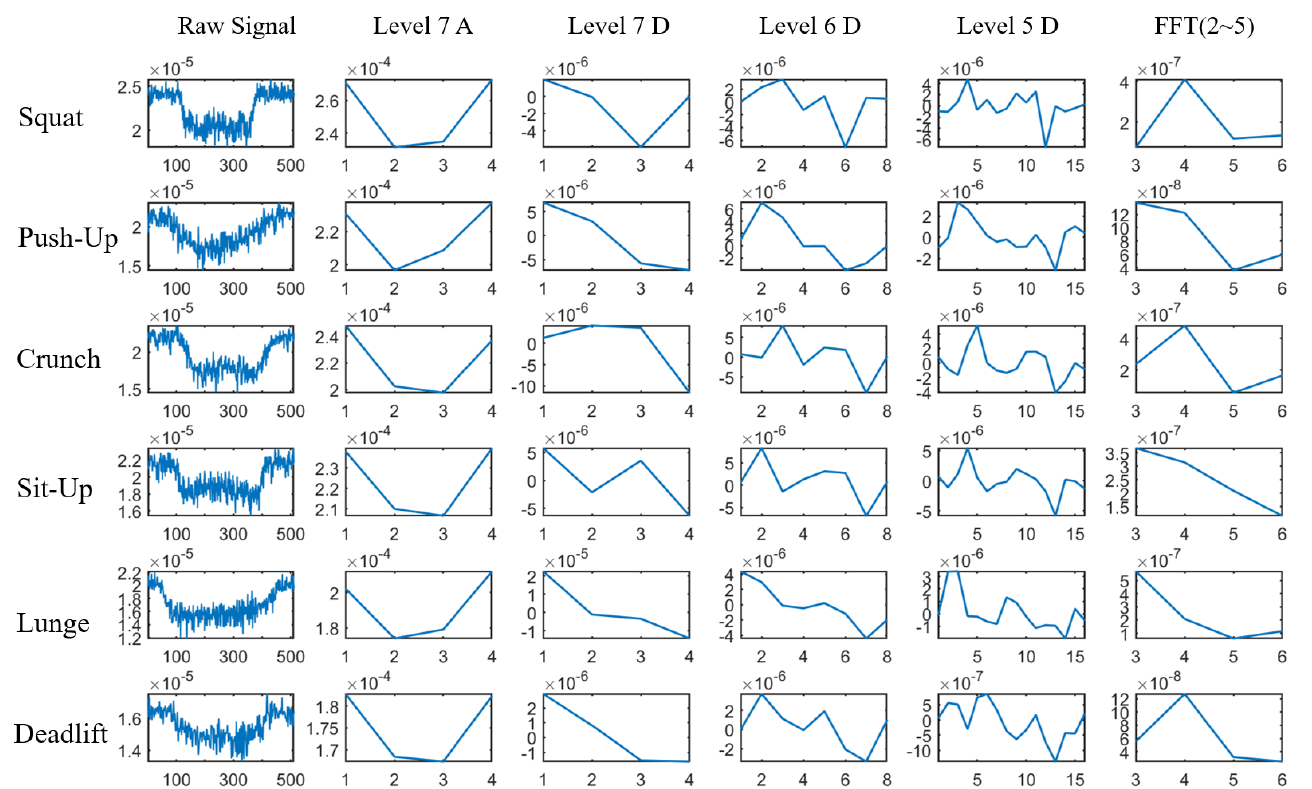
Figure 13. Features extracted from repetitions of six exercise